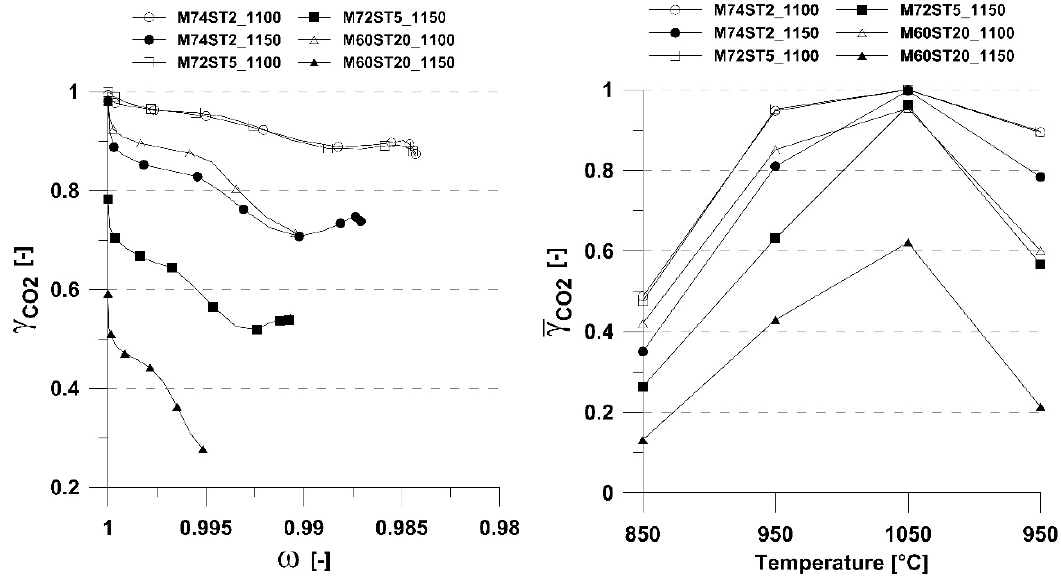
Figure 5. CO 2 yield from methane conversion as a function of oxygen carrier conversion at 950 °C (left) and average CO 2 yield as a function of temperature (right). The straight lines between the points are only meant to increase readability and do not have a physical meaning.